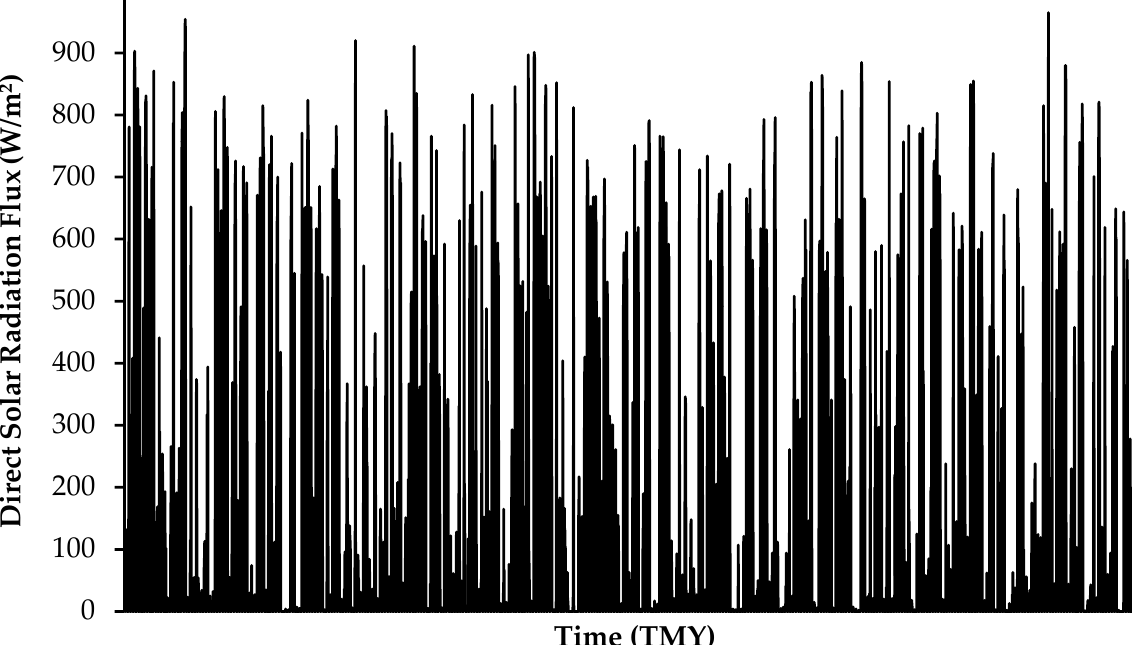
Figure 10. Flexural strength ( F f ) and tensile strength ( F t ) for the composite insulation materials.